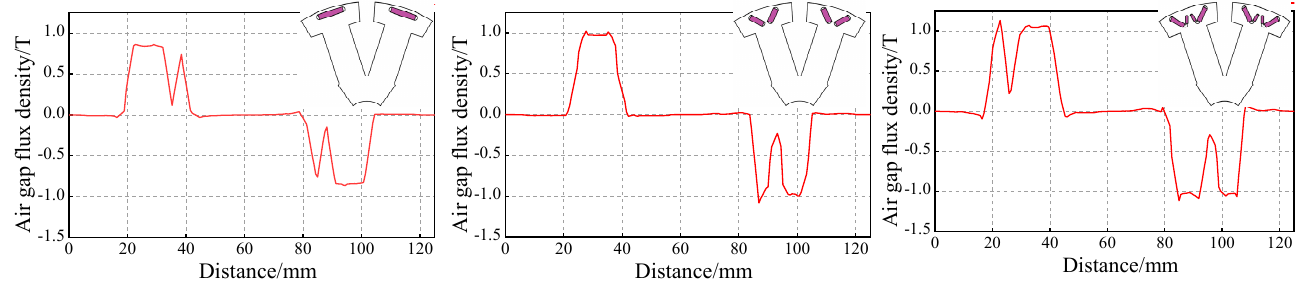
Figure 2. Air-gap flux density of different built-in permanent magnet salient pole rotors.